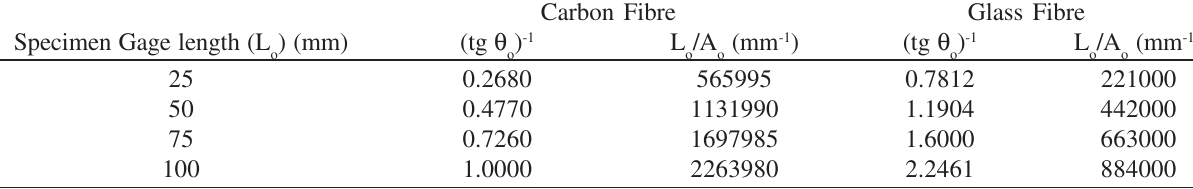
) -1 and gage length/cross section area (L o